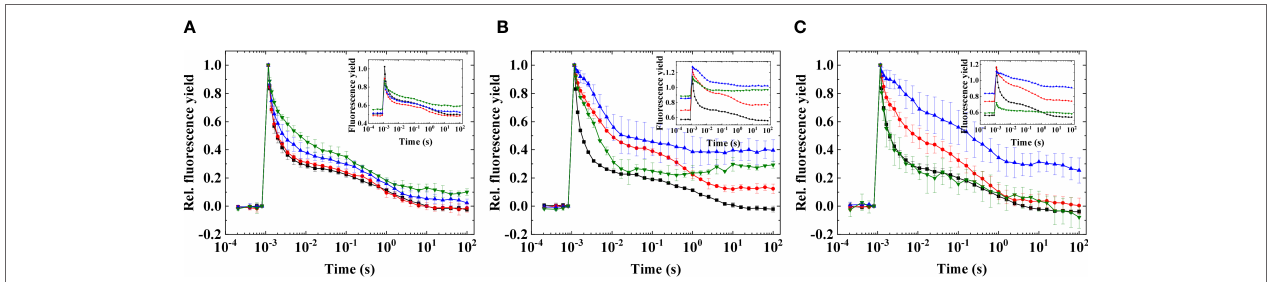
FIGURE 4 | Flash-induced fluorescence relaxation in three different species of Symbiodiniaceae under elevated temperatures. (A) Fugacium kawagutii (CS156), (B) Symbiodinium tridacnidorum (2465), and (C) Symbiodinium microadriaticum (2467), including control (black), 36°C (red), and 38°C (blue), and 40°C (green). The